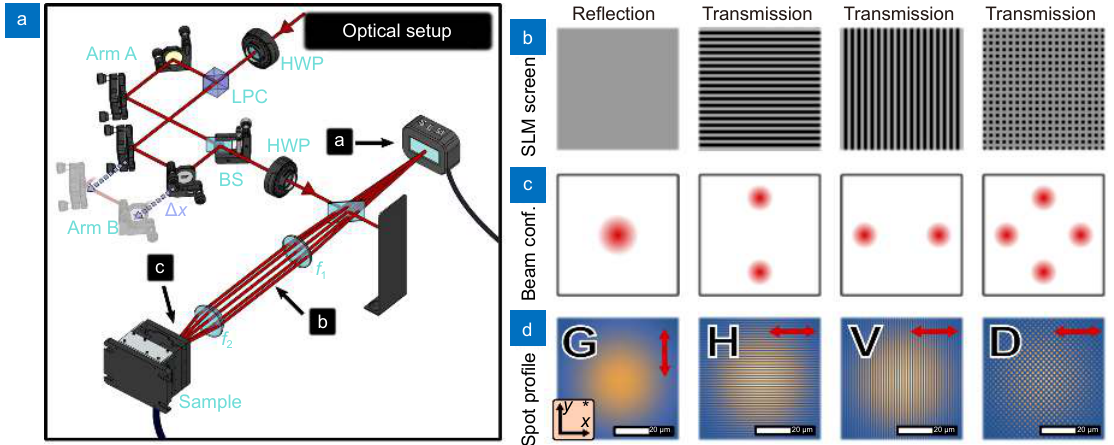
Fig. 1 | ( a ) Experimental setup. Abbreviations: half-wave plate (HWP), linear polarizing cube (LPC), beam splitter (BS), spatial light modulator (SLM), focusing lenses ( f 1 , f 2 ). ( b ) SLM function. ( c ) Spot profile distribution at the sample: Gaussian ( G ) and DLIP ( V , H , D ) profiles. ( d ) The red arrow indicates the polarisation